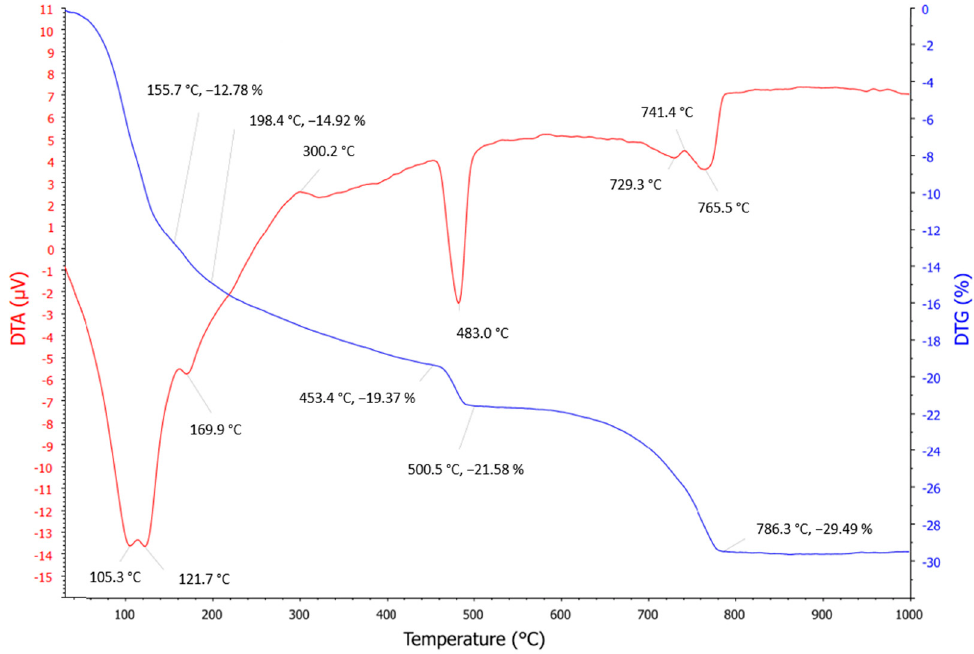
Figure 4. TGA graph of dry concrete sludge.